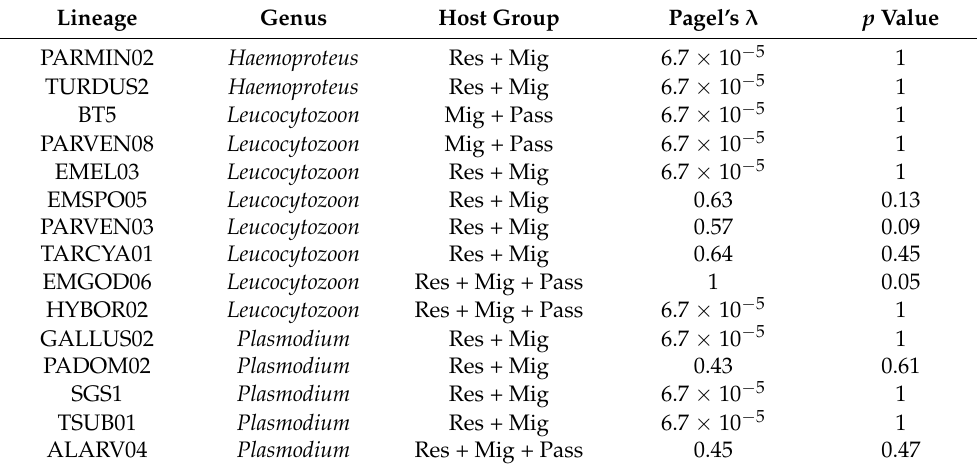
Table 1. Phylogenetic signal of the rates of prevalence of lineages detected in more than one host group. Pagel’s λ ranges from 0 to 1. An λ value close to 1 refers to a strong phylogenetic signal (i.e., closely related host species exhibit a similar prevalence), while an λ value close to 0 refers to a weak phylogenetic signal.